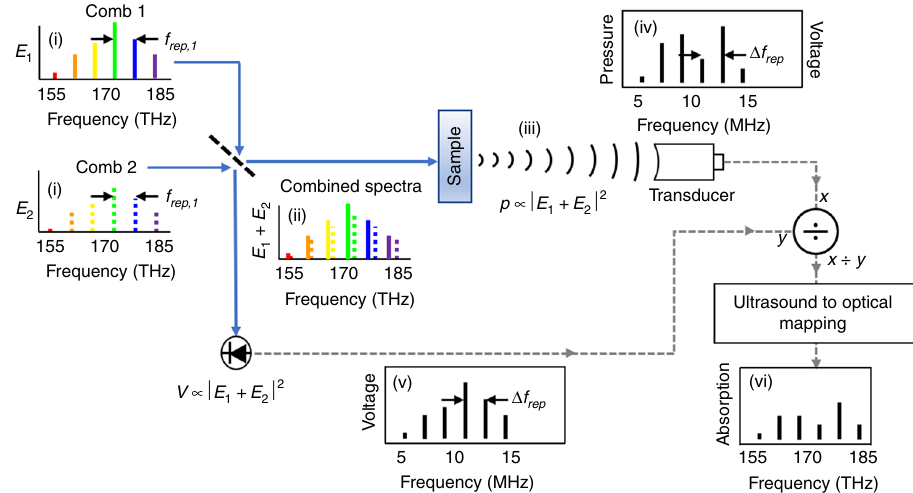
Fig. 1 Schematic of dual-comb photoacoustic spectroscopy. Two frequency combs (i) are combined on a beam splitter and focused onto a sample. The sample absorbs this combined light (ii) and generates localized thermoelastic energy, which results in a PA pressure wave upon transmitting into the water (iii). An ultrasound transducer detects and converts this pressure wave to a voltage signal whose Fourier transform yields an ultrasound signal (iv). Simultaneously, the combined comb light from the other beam-splitter branch is focused onto a photodetector to record the optical excitation spectrum as in DCS (v). The spectrally resolved DCPAS response is normalized to the intensity of the DCS excitation spectrum (v). Then a one-to-one mapping between the ultrasound and optical frequencies is applied to yield the sample ’ s optical absorption spectrum (vi). Note that the comb spectra are not to scale as there are 95,000 comb teeth within the ≈ 15 THz spectral bandwidth used in these